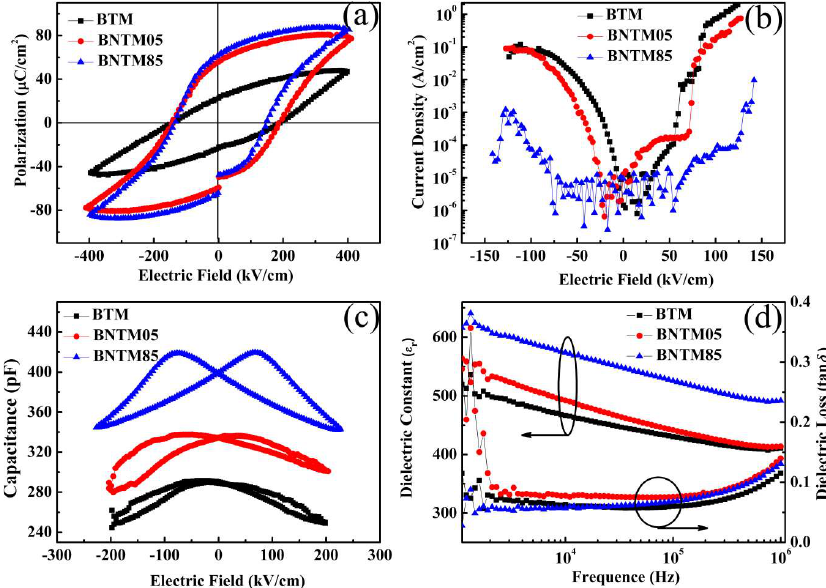
Figure. 3. The electrical properties of BTM, BNTM05 and BNTM85 for ( a ) P – E hysteresis loops at 1